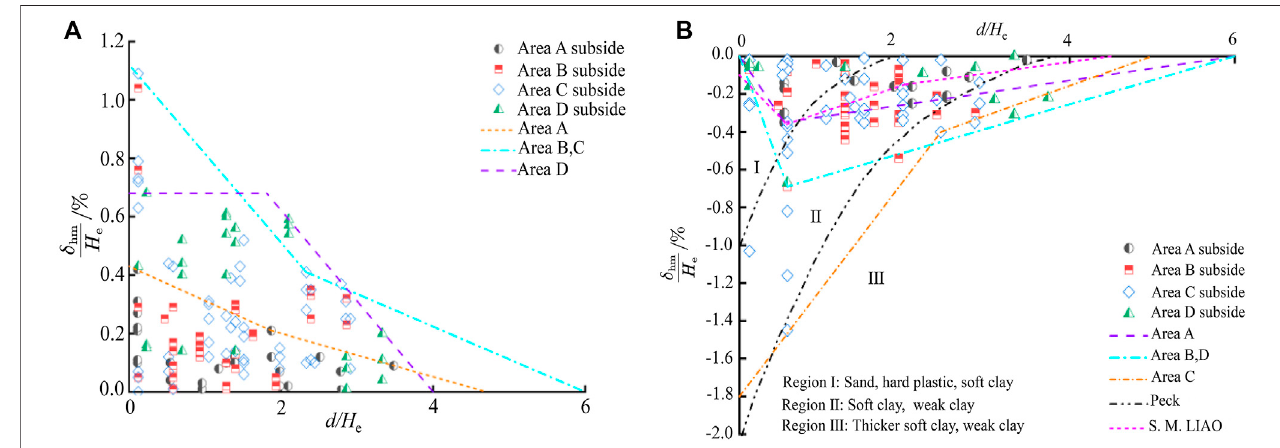
FIGURE 8 | Surface uplift morphology behind the wall. (A) Surface uplift form behind the wall. (B) Surface subsidence form behind the wall.